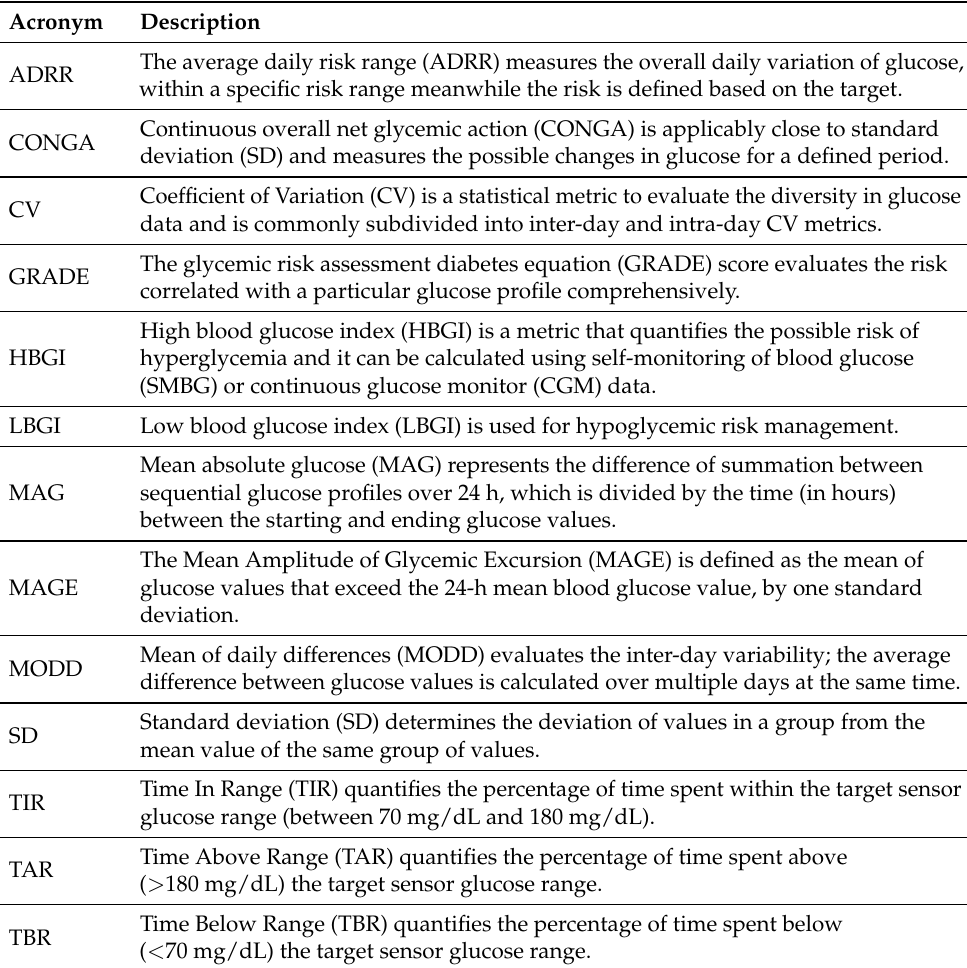
Table 1. Clinically Approved Glucose Variability